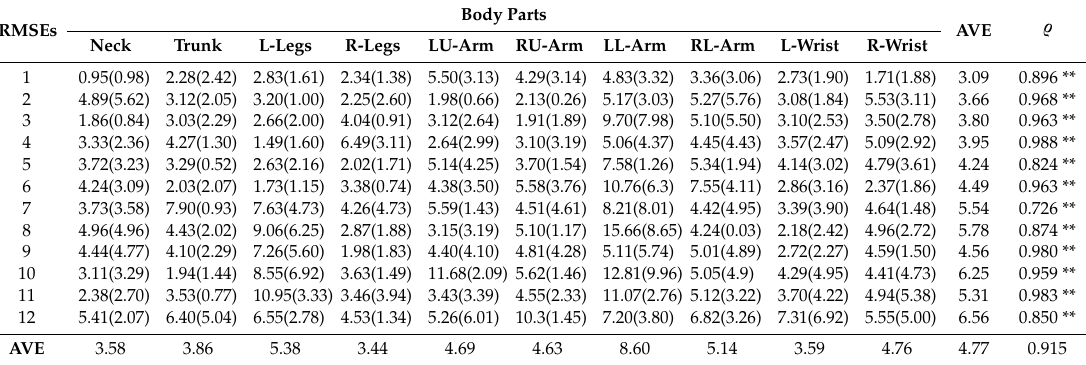
Table 3. Comparison of RMSE ( + SD) and (cid:37) , and consistency between Quick Capture and the motion capture